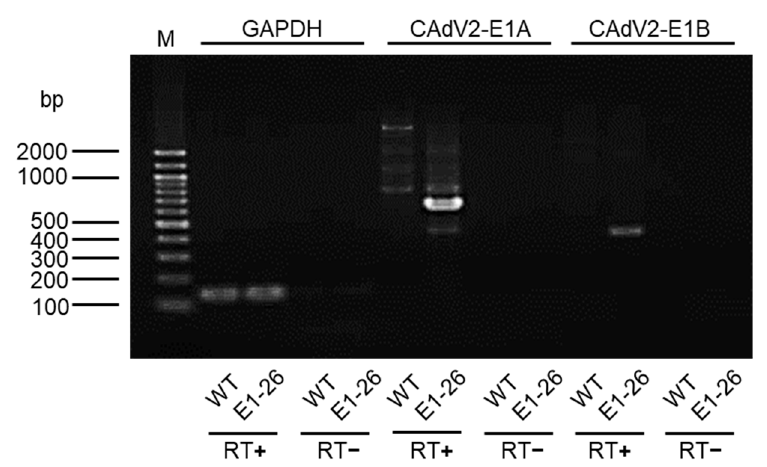
Figure 5. CAdV2 E1 gene expression in MDCK-E1-26 cells. RNA was extracted from MDCK wild-type (WT) or MDCK-CAdV2-E1-26 cells (E1-26). RT-PCR was performed using primers specific for canine glyceraldehyde 3-phosphate dehydrogenase GAPDH , CAdV2- E1A , and CAdV2- E1B , with ( + ) or without ( − ) reverse transcriptase (RT). M: 100-bp DNA ladder marker.